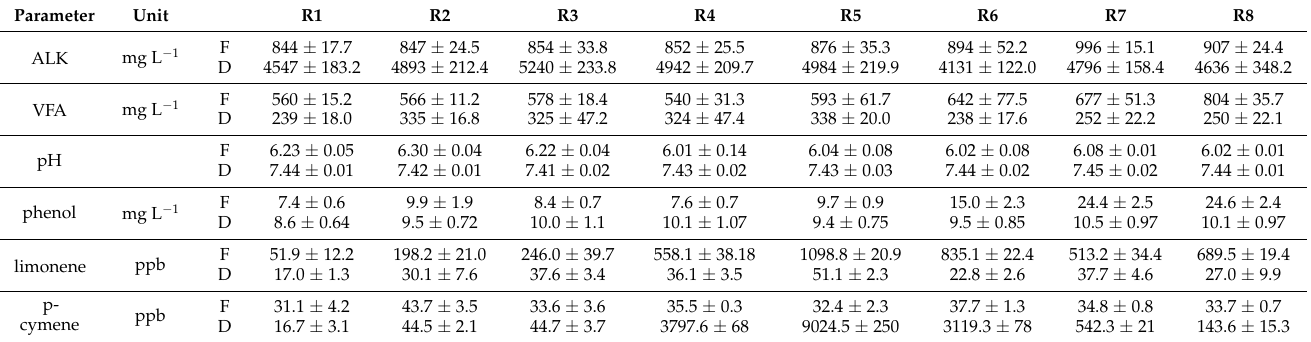
Table 3. The pH values and ALK, VFA, phenol, limonene and p-cymene concentrations in feedstock (F) and digestate (D) (average values and standard deviation are